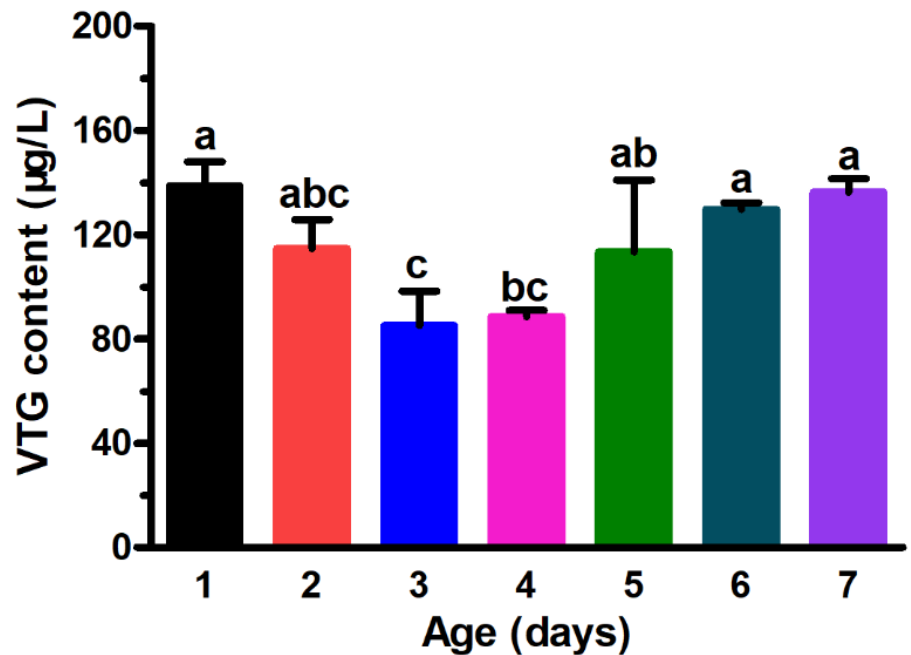
Figure 1. The vitellogenin (VTG) levels of Grapholita molesta females of different ages. The data are shown as the mean ± standard error. The different lower-case letters above the histogram bars indicate significant differences between VTG levels in females of different ages (ANOVA: HSD test, p < 0.05).